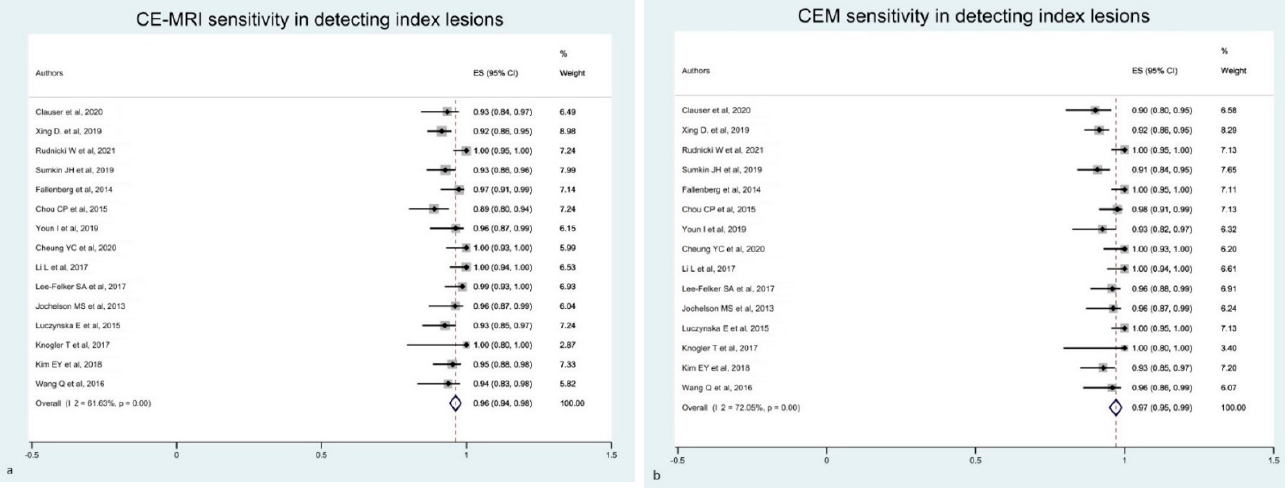
Figure 4. Forest plot of the estimated pooled sensitivity of breast CE-MRI ( a ) and CME ( b ) in the detection of pathological breast index lesions. The estimated pooled sensitivity of CE-MRI ( a ) was 0.96 (95% CI 0.94 – 0.98), with a moderate heterogeneity (I 2 = 61.63% p = 0.001). Estimated pooled sensitivity of CME ( b ) was 0.97 (95% CI 0.95 – 0.99), with a moderate heterogeneity (I 2 = 72.05% p = 0.001) [16,17,18,19,21,22,23,24,25,26,28,29,30,33,34].